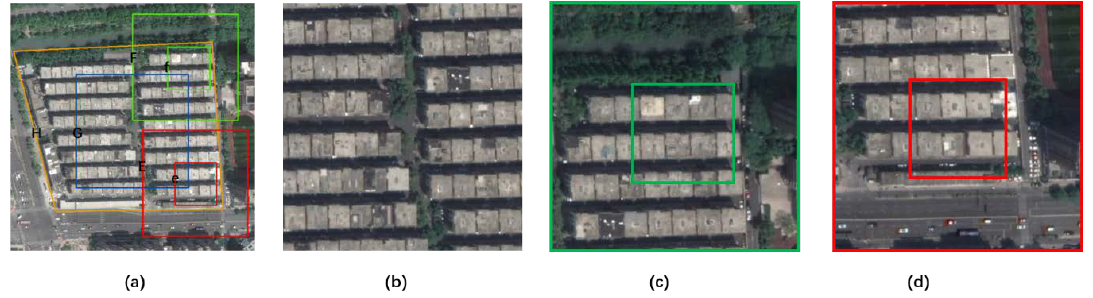
Figure 1. ( a ) Image e and f are small-scale images. Image E and F are large-scale images constructed by the geometric center of e and f, respectively. Large-scale image G is the center of the block. H is the boundary of block; ( b ) correspond to G in ( a ); ( c ) correspond to F, f in ( a ); ( d ) correspond to E, e in ( a ).